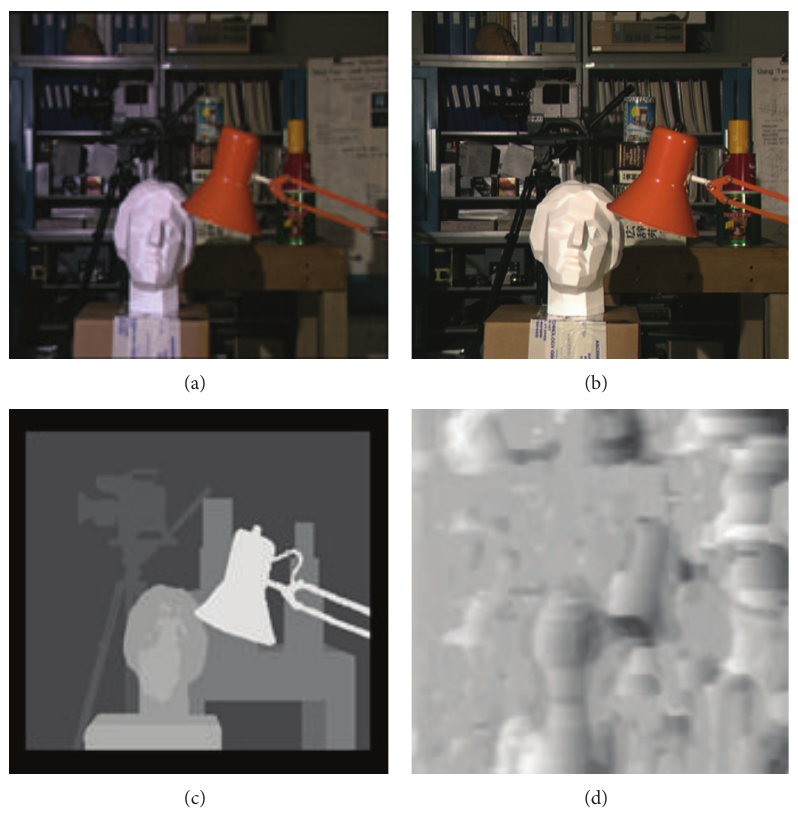
Figure 3: The disparity map generated by using conventional SAD for tsukuba stereo image pair with 50% of total pixels changed within image due to 10% illumination variation. (a) and (b) The left and right tsukuba image with varying illumination. (c) The ground truth. (d) The disparity map generated using SAD method for images (a) and